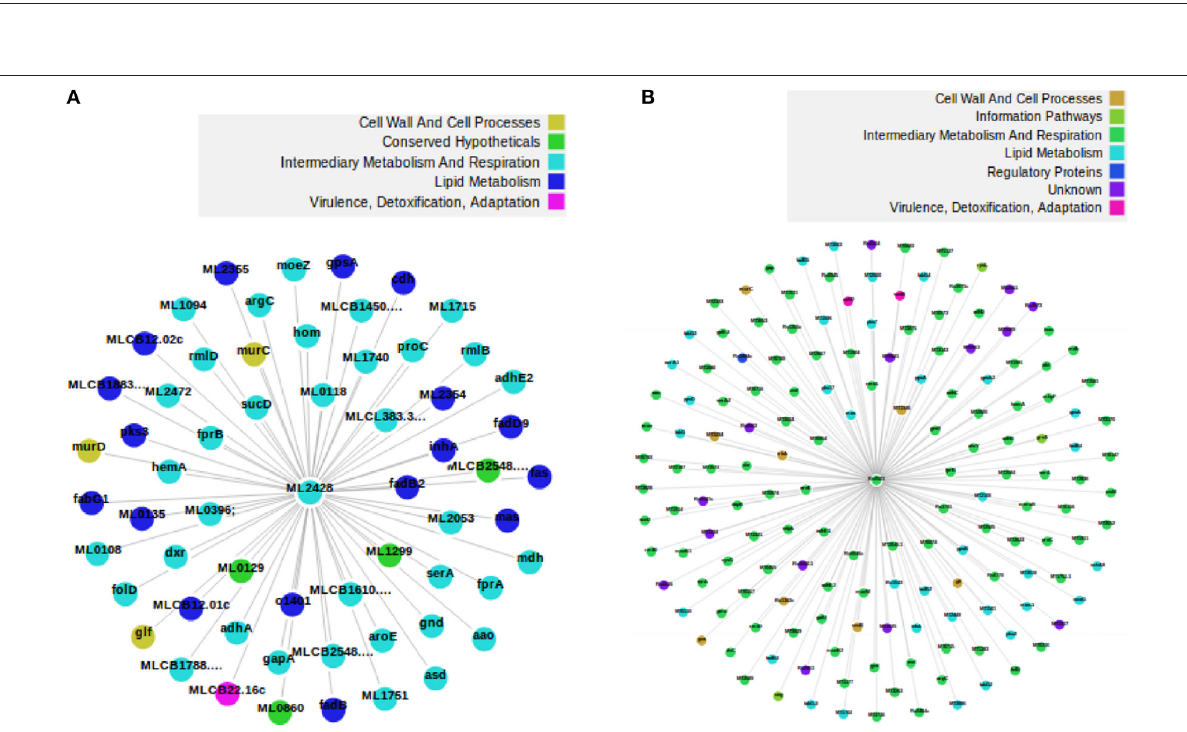
Frontiers in Genetics | www.frontiersin.org